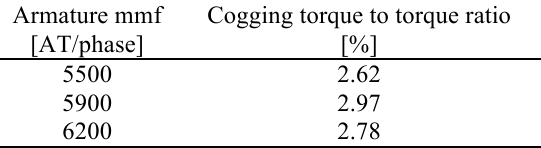
Table 4: Peak-to-peak cogging torque to torque ratio